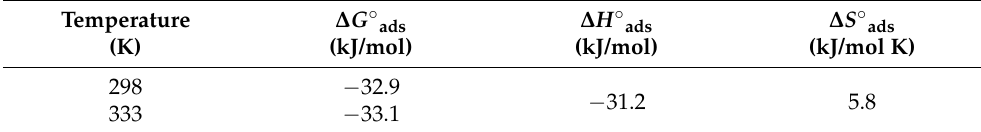
Table 1. Thermodynamic parameters of low-carbon steel corrosion in HCl with different concentra- tions of CoO/Co 3 O 4 NPs at 298 and 333